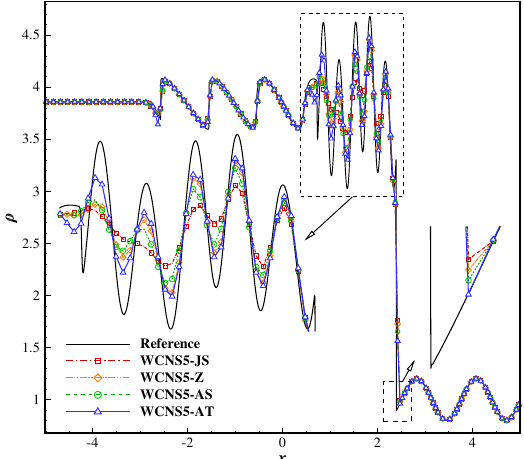
Figure 14. Density distribution of Shu-Osher problem.